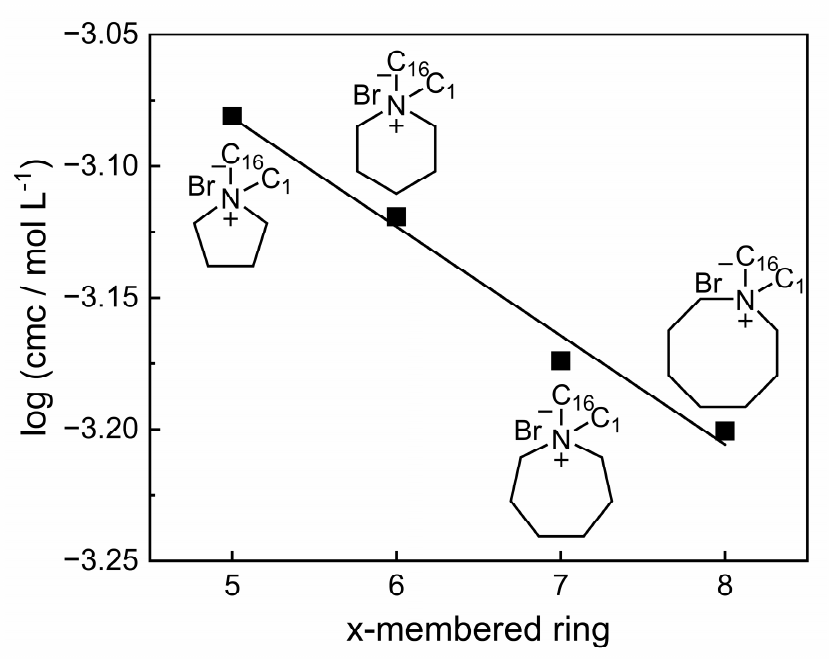
Figure 4. Log critical micelle concentration (cmc) as a function of the size of heterocyclic amine ring structures of cationic ionic liquid-based surfactants. Data taken from Schnee and Palmer [150].